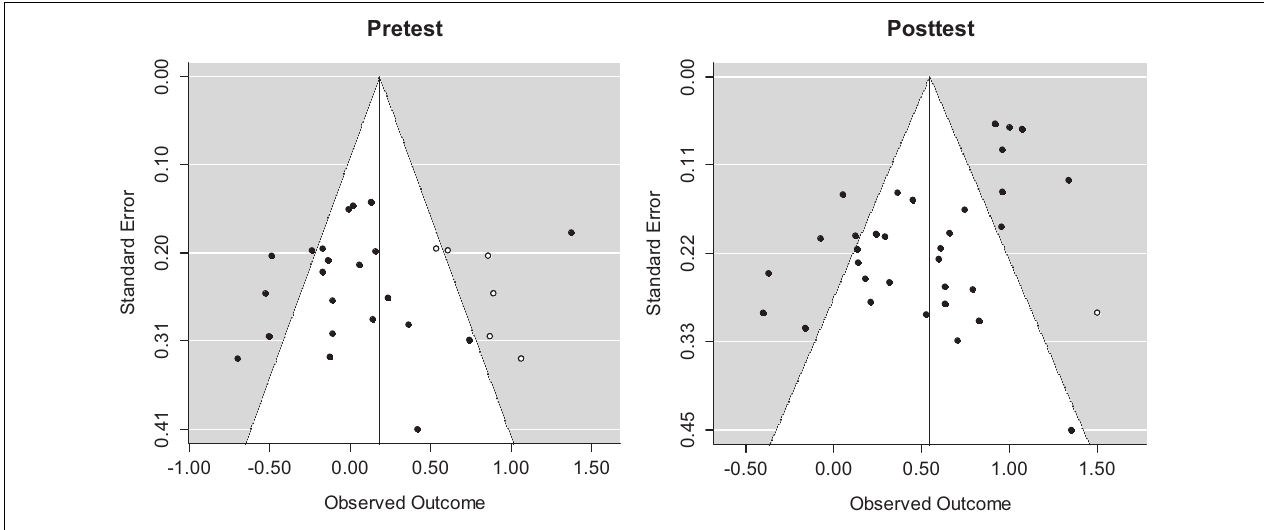
FIGURE 1 | Funnel plots after applying a trim-and-fill method to reduce the effects of the existing publication bias. Standard errors on the y -axis indicate the precision of each study; the largest N -size studies have the smallest standard error. Effect sizes d for each study are plotted on the x -axis. Diagonal lines show the expected 95% confidence intervals around the summary estimate. White dots indicate the missing studies estimated by the trim-and-fill method.